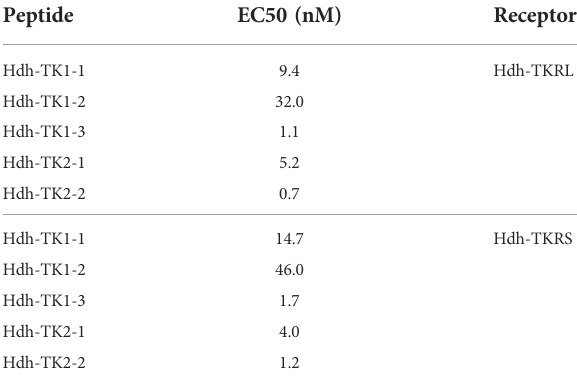
TABLE 4 Half-maximal effective concentrations (EC50) of Hdh-TK peptides on intracellular Ca 2+